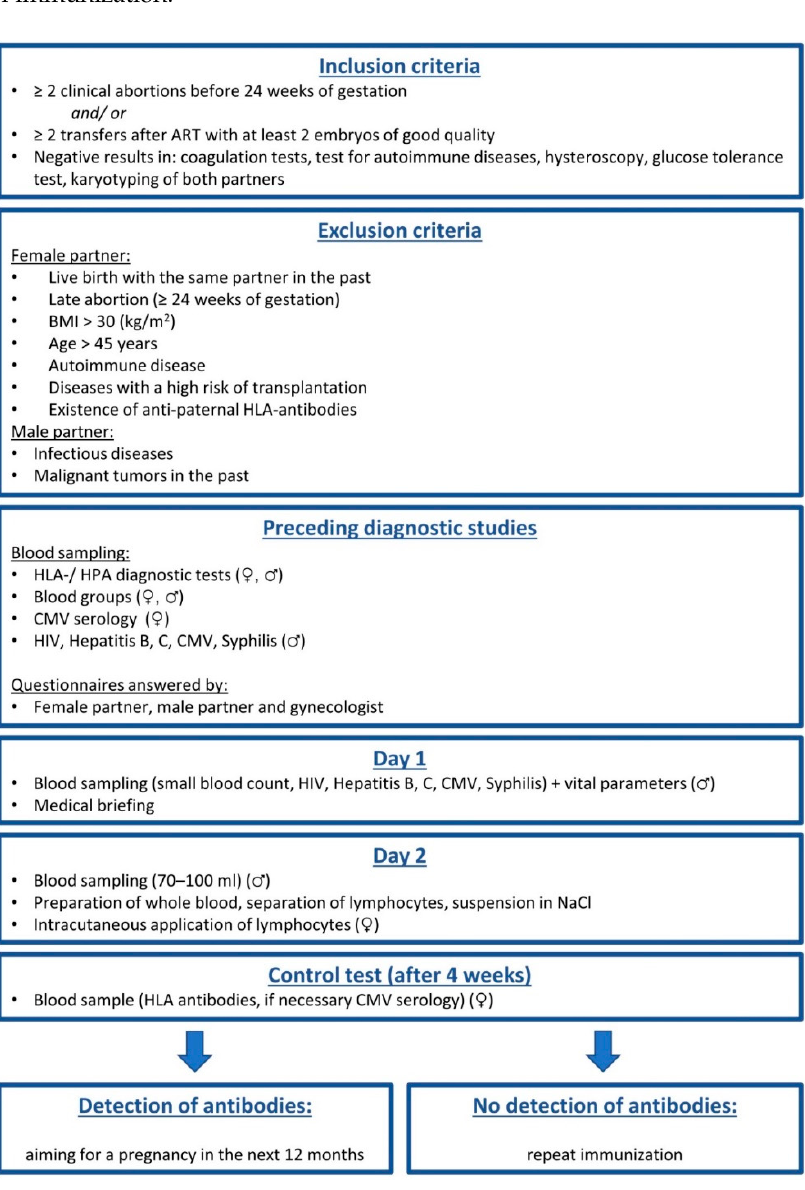
Figure 1. Schematic sequence of immunization. Abbreviations: ART: assisted reproductive technol- ogy, HLA: human leukocyte antigen, HPA: human platelet antigen, CMV: cytomegalovirus.